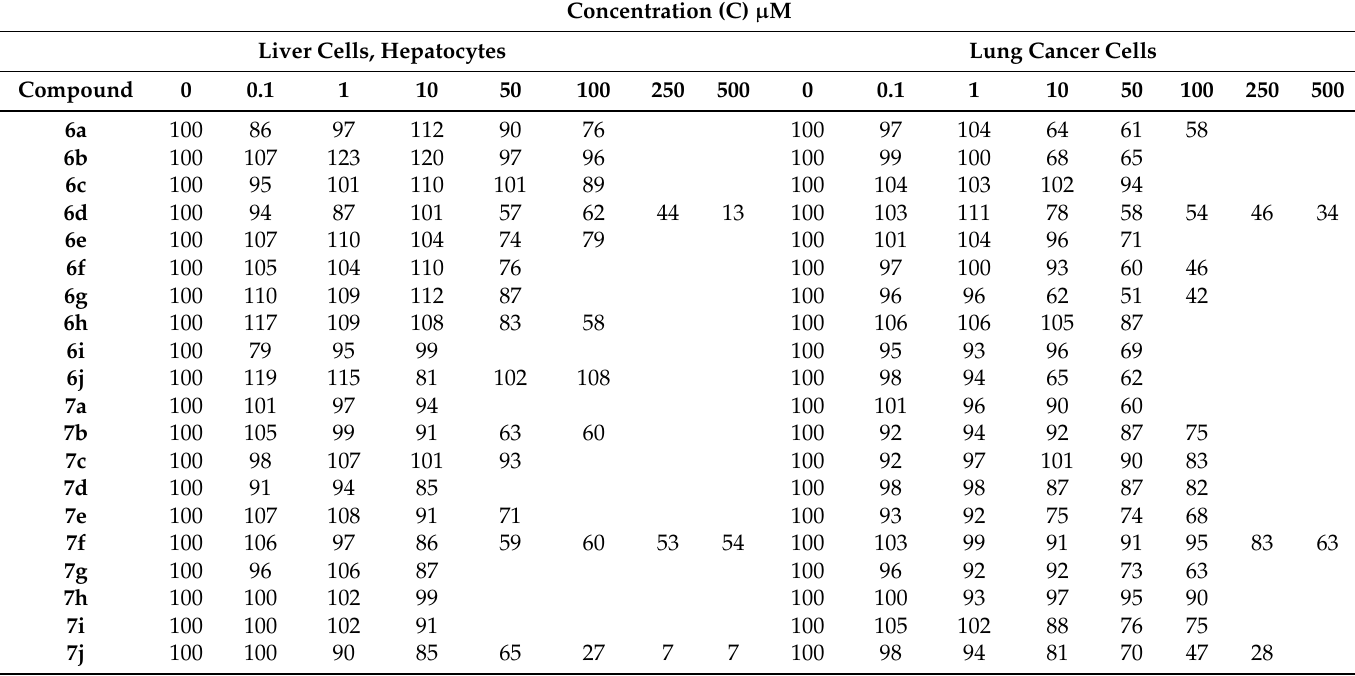
Table 2. Cell viability shown in % for benzoxazole derivatives and their